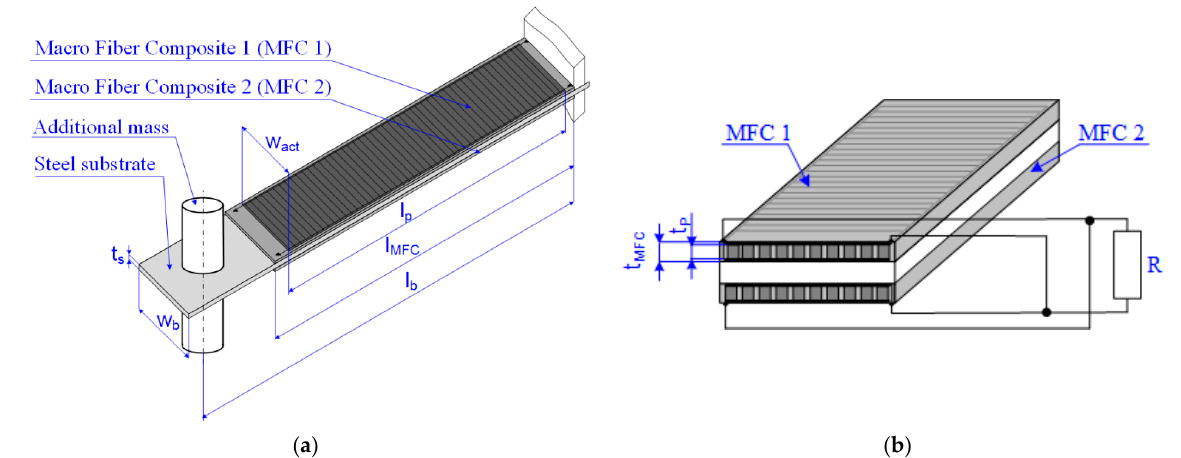
Figure 2. Piezoelectric cantilever beam: ( a ) structure; ( b ) electric connection of MFC patches. Table 1. Geometric parameters of the manufactured cantilever beam